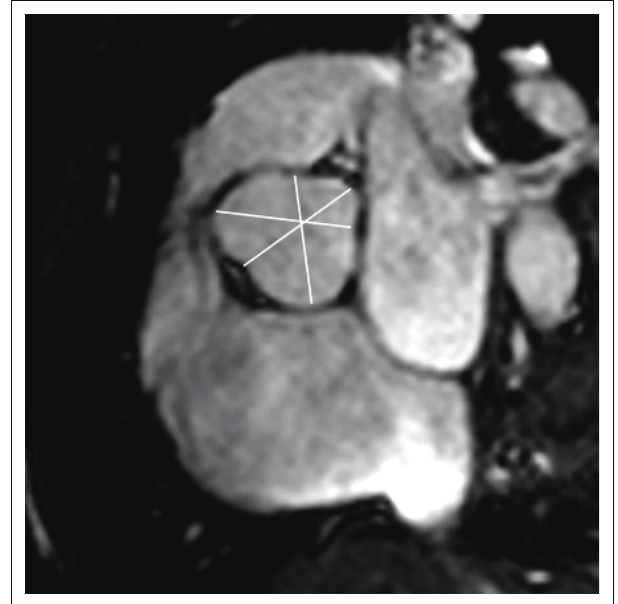
FIGURE 17: Axial cine SSFP image through the aortic valve. The second method of measuring the aortic valve is to measure the distances from the sinus of Valsalva to the opposite commissure (white lines). This is called the sinus-to- commissure measurement.